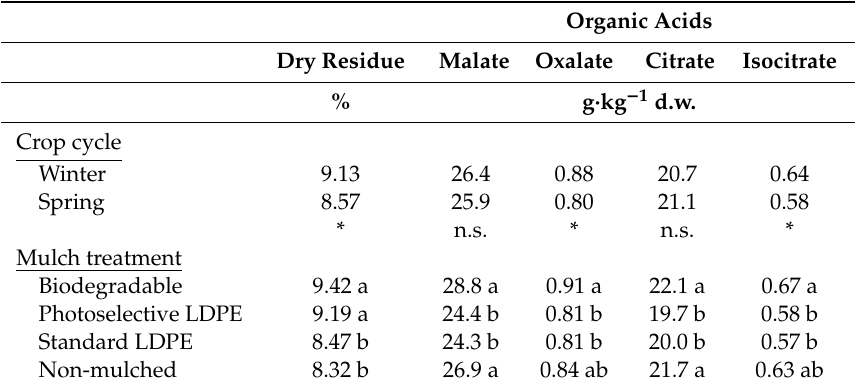
Table 3. Mean values of leaf quality indicators of perennial wall rocket as a ff ected by crop cycle and mulch treatment.